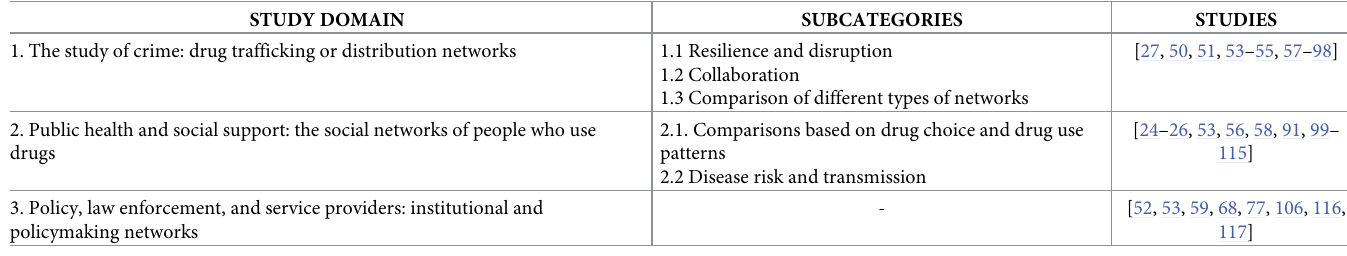
Table 2. Summary of study domains, subcategories and corresponding